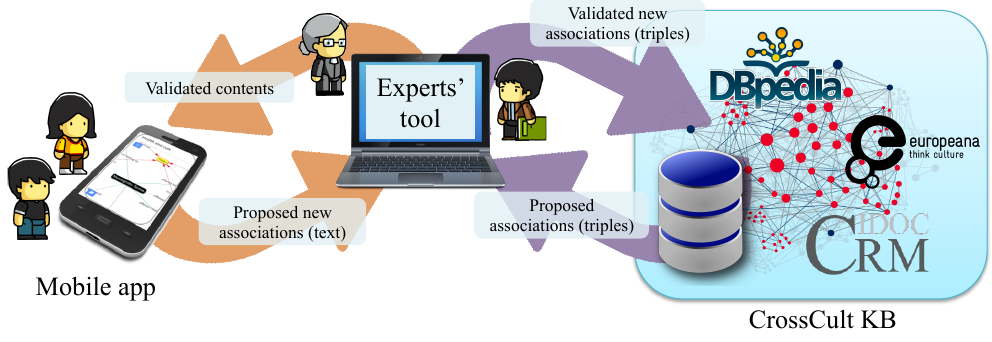
Figure 1. High-level diagram of the